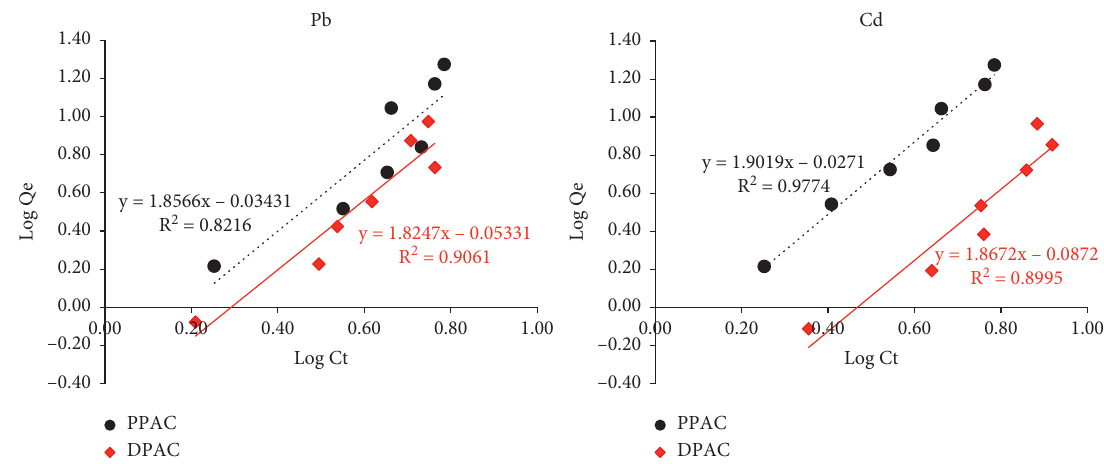
Figure 11: Freundlich isotherm plot for adsorption of Pb(II) and Cd(II) ions by the DPAC and PPAC adsorbents.